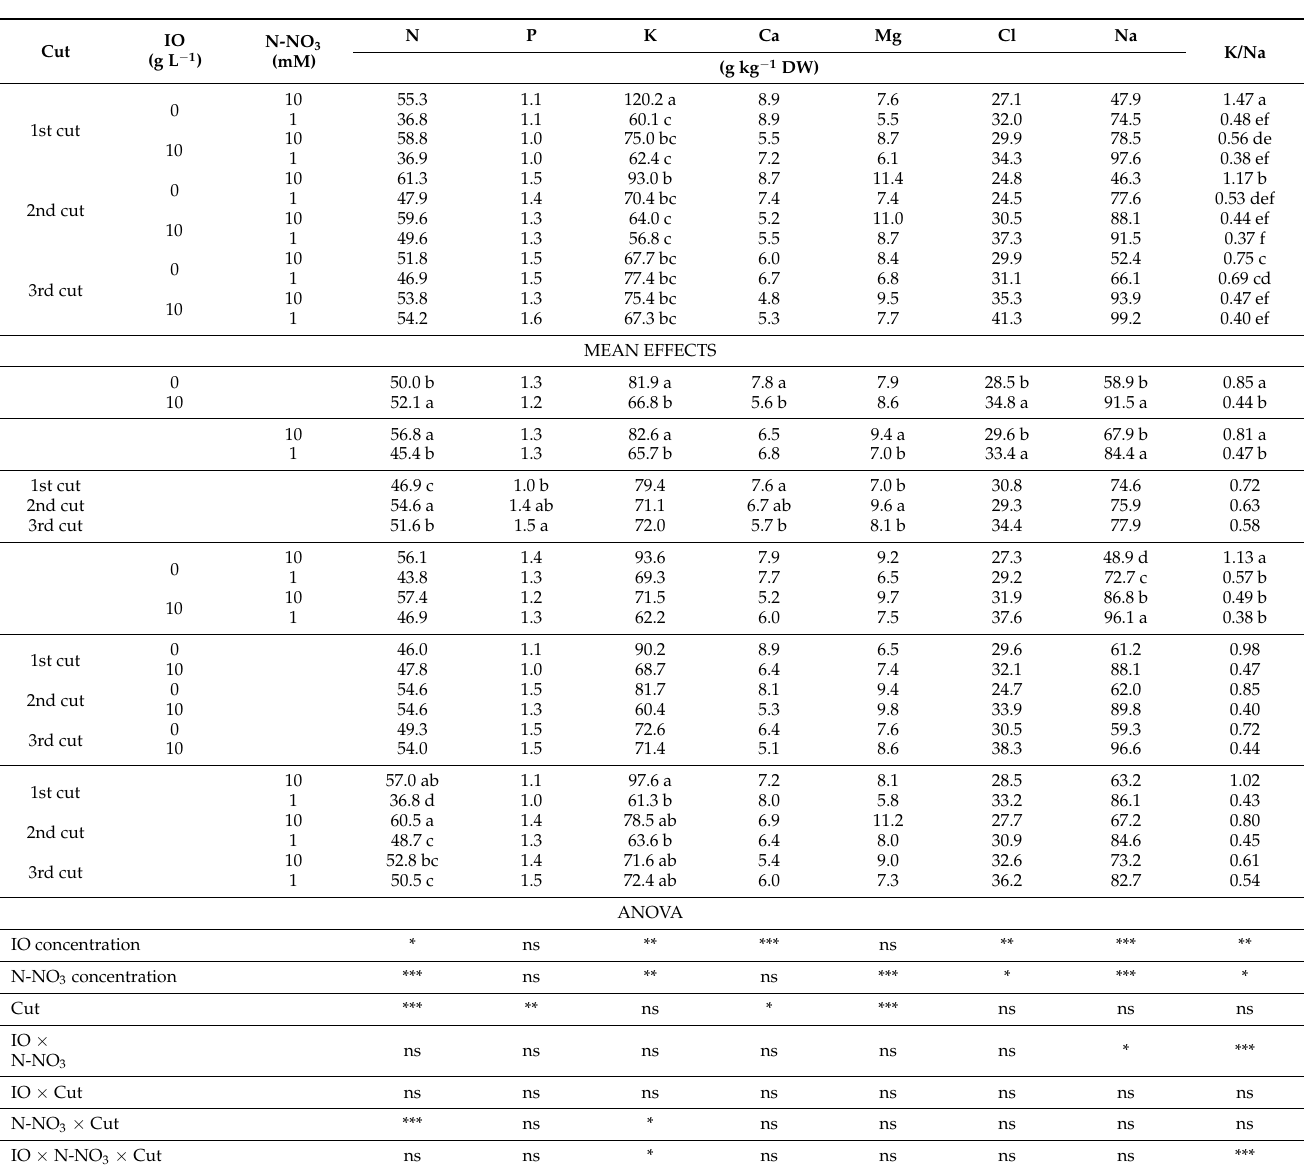
Table 9. Leaf concentration of nitrogen (N); phosphorus (P); potassium (K); sodium (Na); calcium (Ca); magnesium (Mg); and chloride (Cl), and K/Na molar ratio of sea beet plants grown hydroponically with different concentrations of the sea salt Instant Ocean (IO; 0 and 10 g L − 1 ) and nitrogen (1 and 10 N-NO 3 mM) in the nutrient solution. The leaves were harvested trice during the experiment (see Table 1 for more detailed information in the